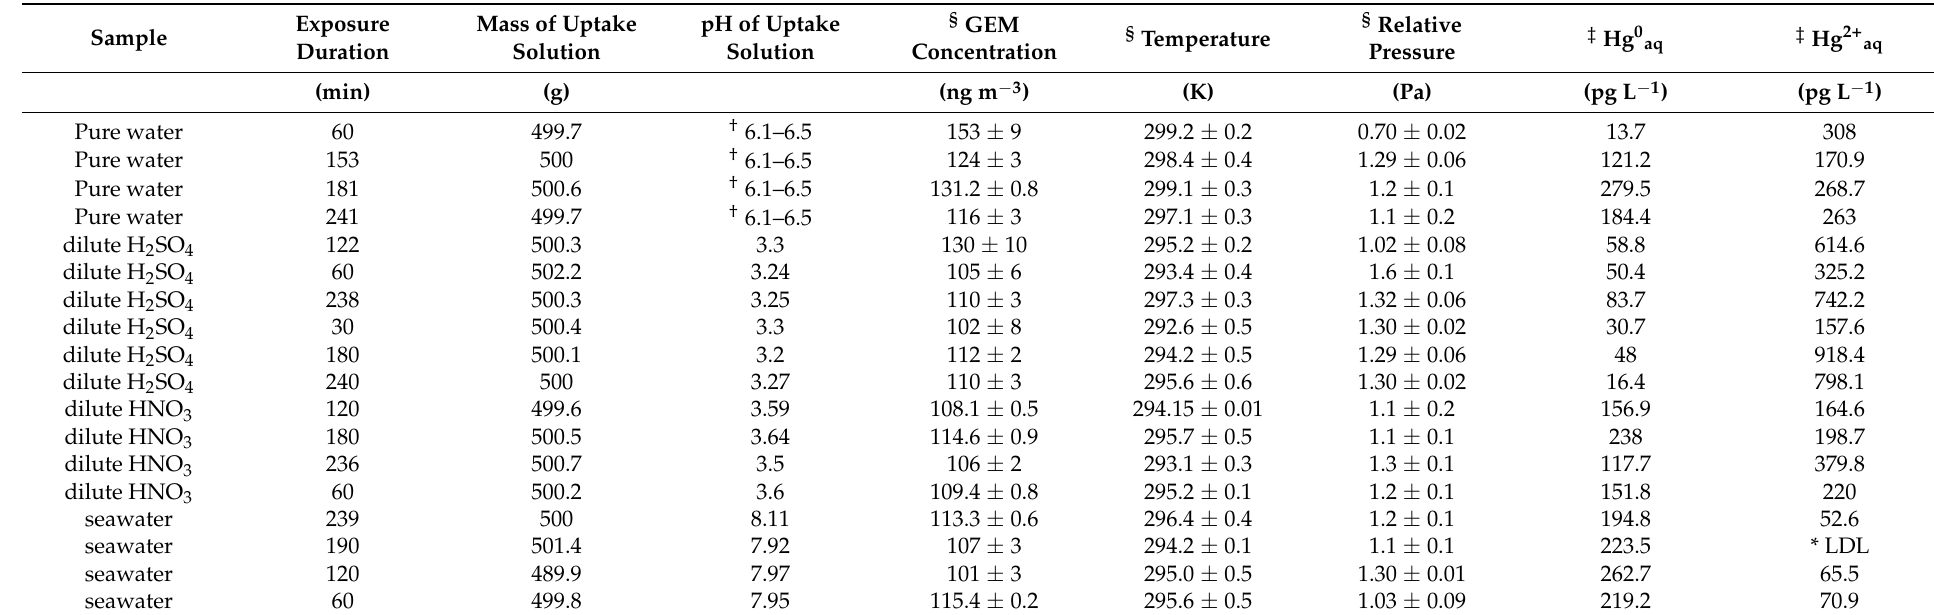
Table 2. Results of GEM uptake experiments by variety of bulk